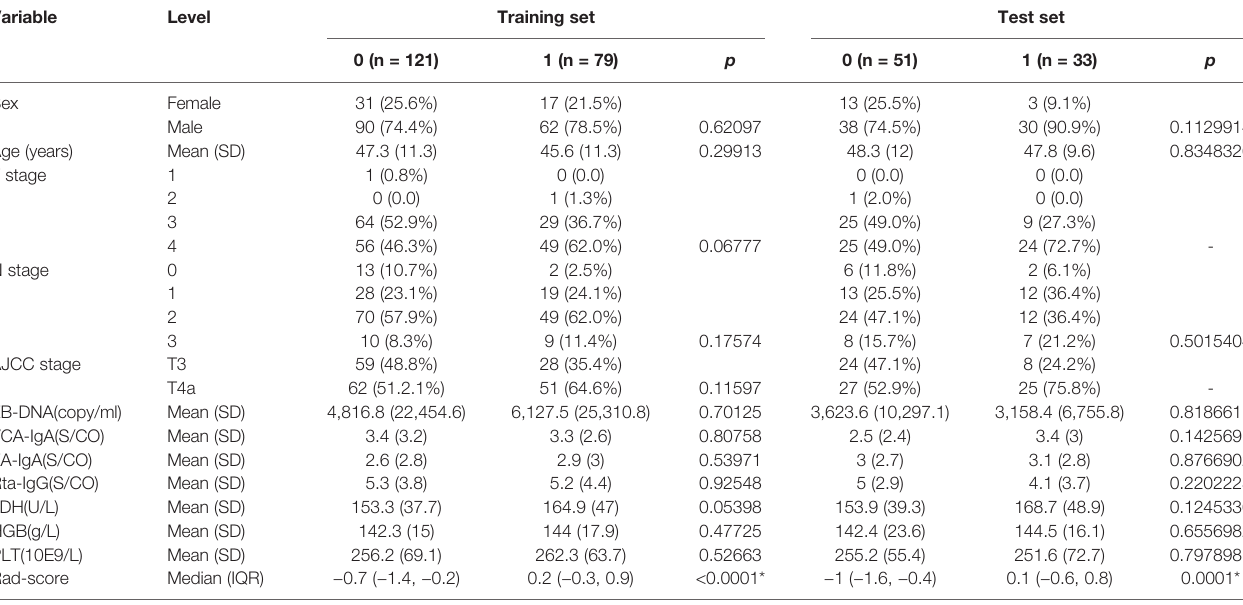
TABLE 2 | Clinical features of patients randomly assigned to the enhanced T1-weighted imaging (T1WI) sequence group. Variable Level Training